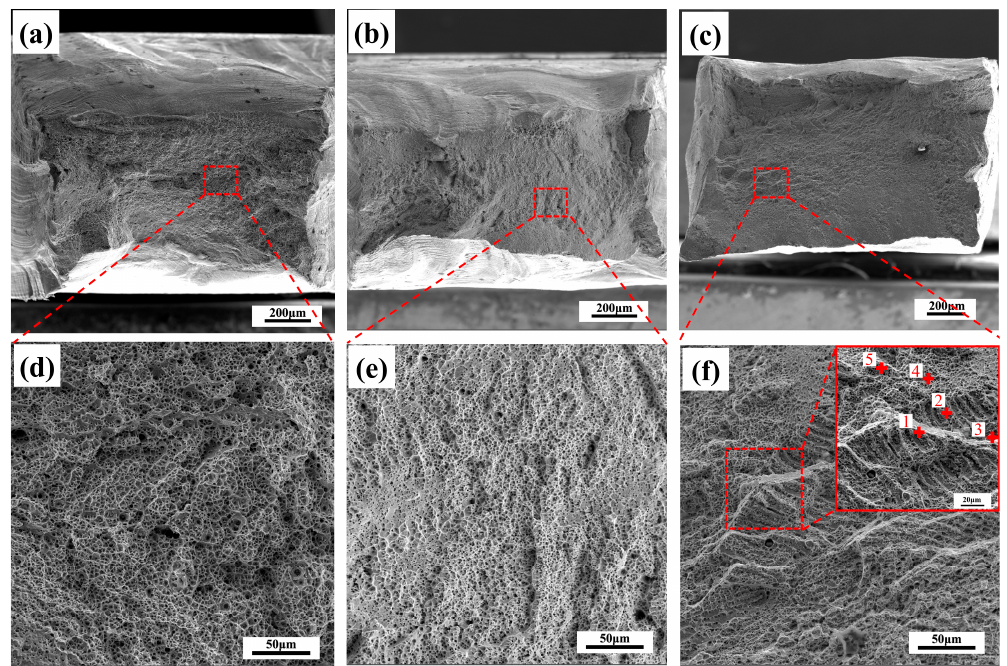
Figure 9. Fracture morphology of as-welded samples. ( a , d ) CoCrFeNi/304ss welded joint; ( b , e ) CoCrNi/304ss welded joint; ( c , f ) CoNiV/304ss welded joint. Note that the inset in ( f ) discloses the EDS positions with numbers of 1~5. Table 4. EDS results of representative positions are indicated in Figure